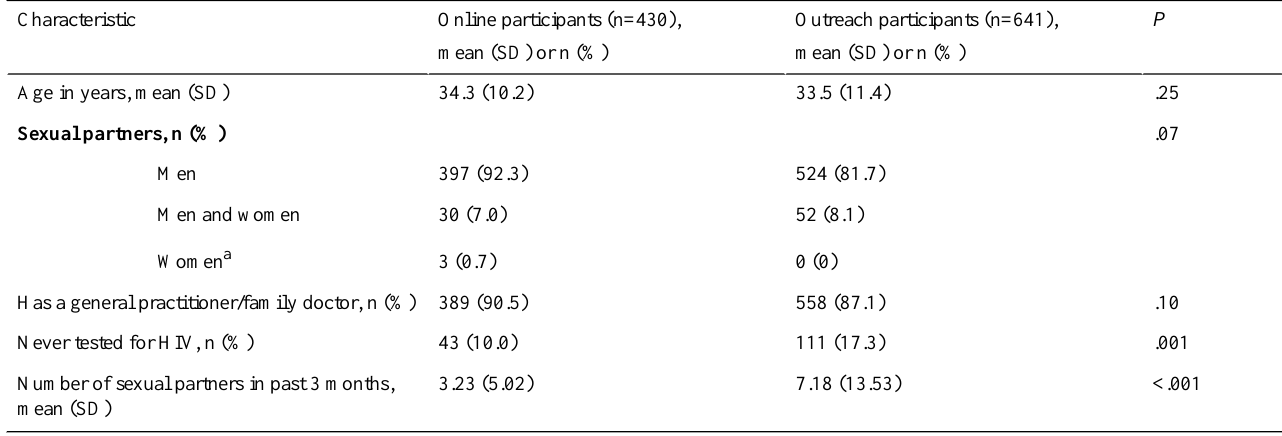
Table 1. Characteristics of study